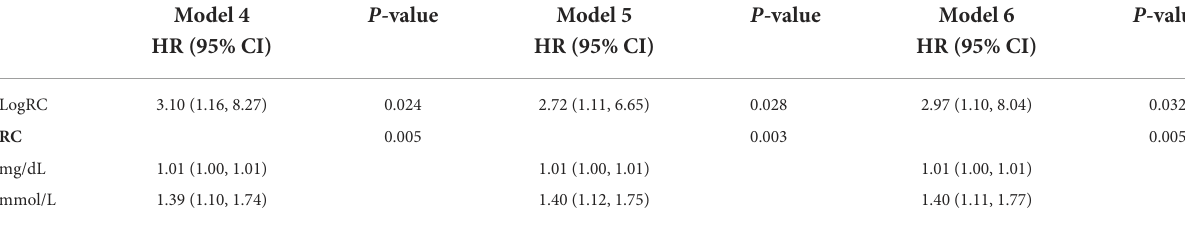
TABLE 3 Cox models for cardiovascular mortality for logRC, RC (continuous variables) after additional adjustment in the pooled cohort.